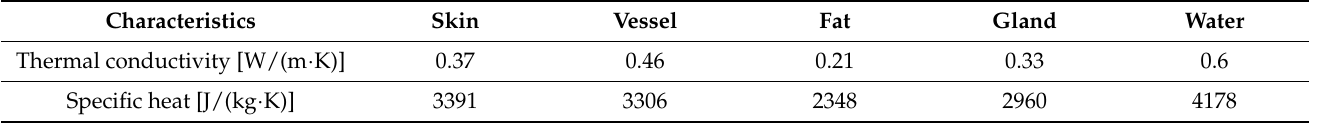
Table 2. Thermodynamic parameters corresponding to various parts of breast tissues used for simulation of heat deposition, diffusion, and the subsequent calculation of lesion area [36].